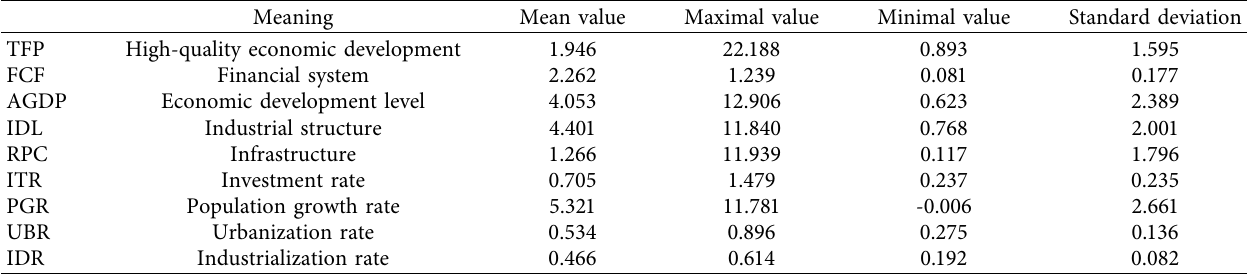
Table 3: Descriptive statistics of